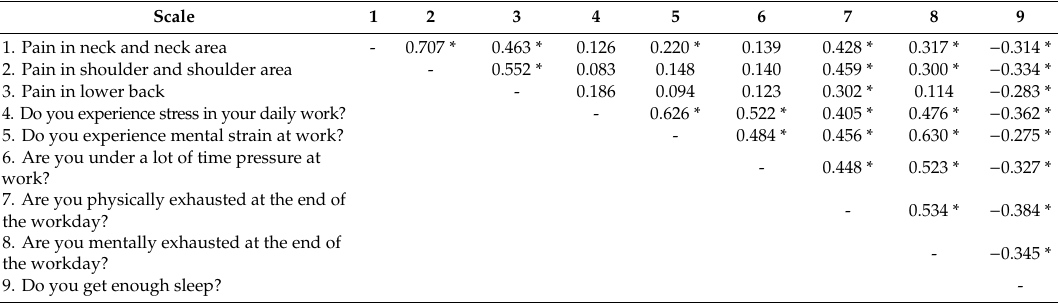
Table 4. Results of the correlation between pain / discomfort in the neck and neck area, shoulder and shoulder area, and lower back and stressful factors in the working environment and lack of adequate